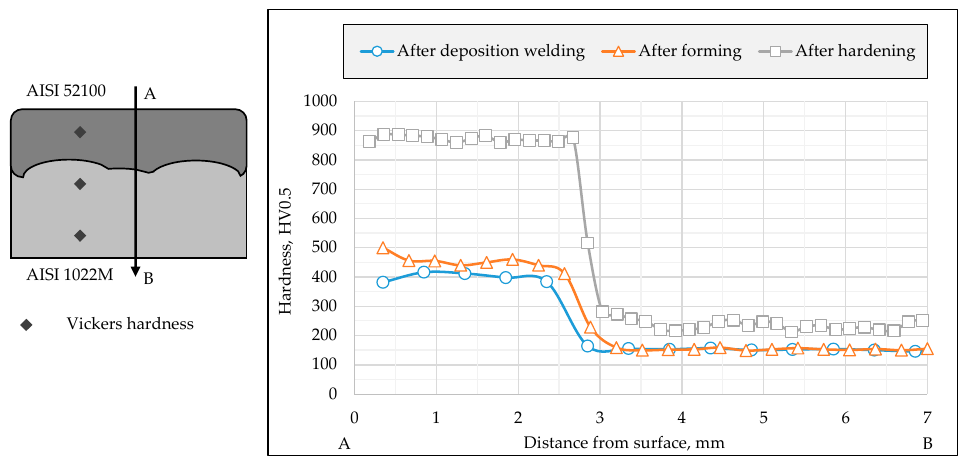
Figure 9. Hardness profiles of the hybrid bearing washers.